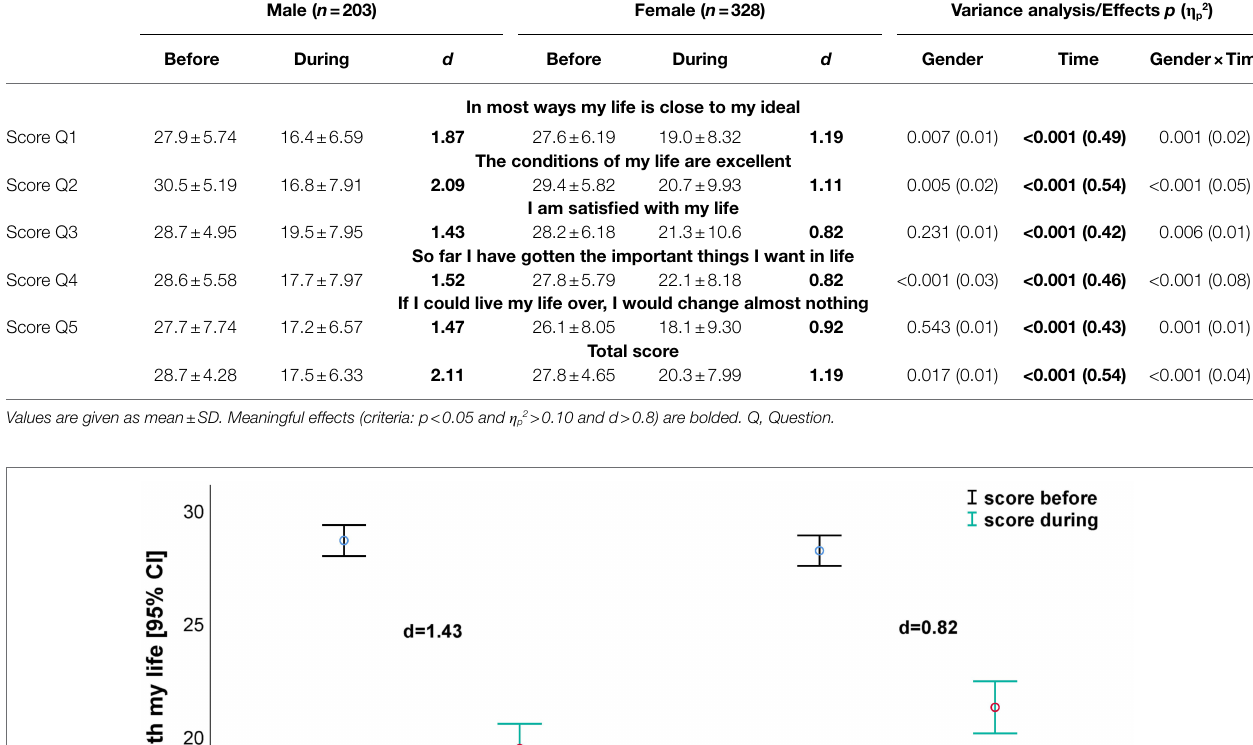
TABLE 4 Comparison of “satisfaction with life” parameters depending on sex before and during confinement. Male ( n = 203) Female ( n = 328) Variance analysis/Effects p ( η p2 ) Before During d Before During d Gender Time Gender × Time In most ways my life is close to my ideal